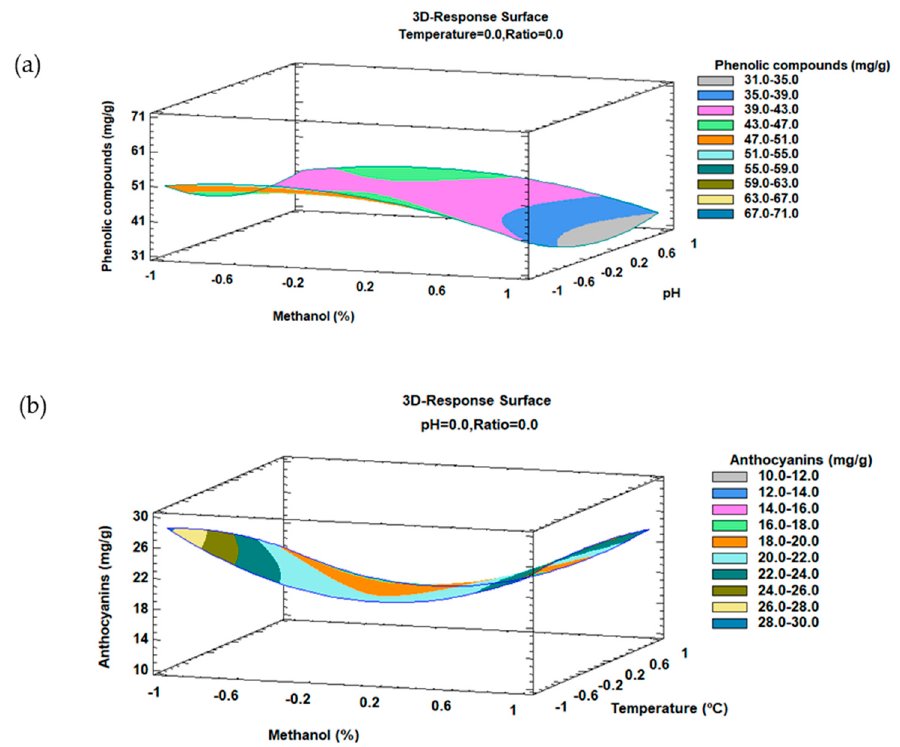
Figure 2. 3D surface plots of the Box–Behnken design using polynomial equations: ( a ) solvent composition and pH on the total phenolic compound extraction, and ( b ) temperature and solvent composition on the total anthocyanin extraction.